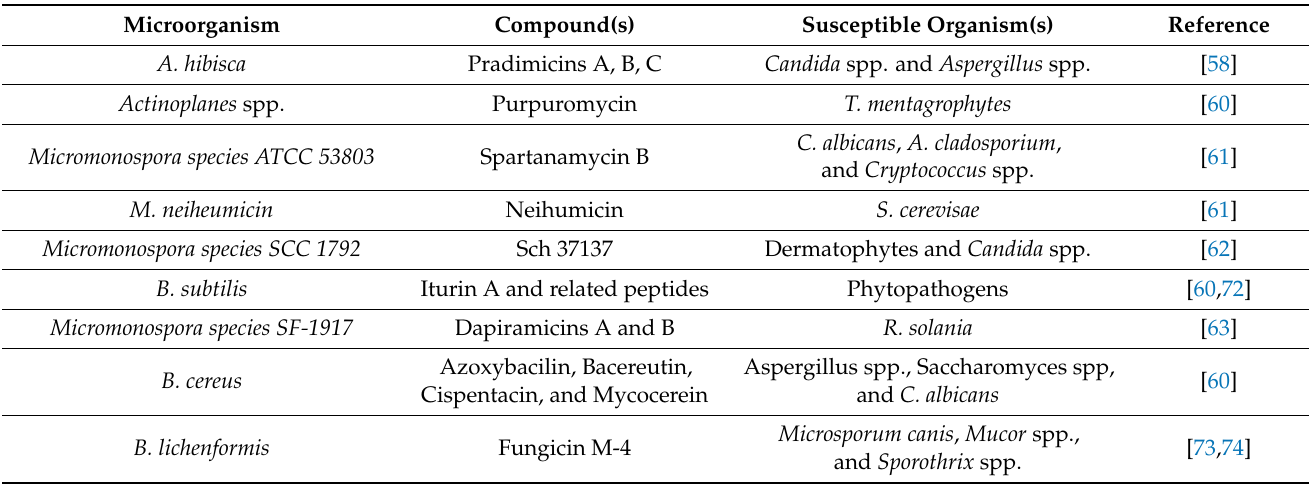
Table 3. Bacterial sources of antifungal